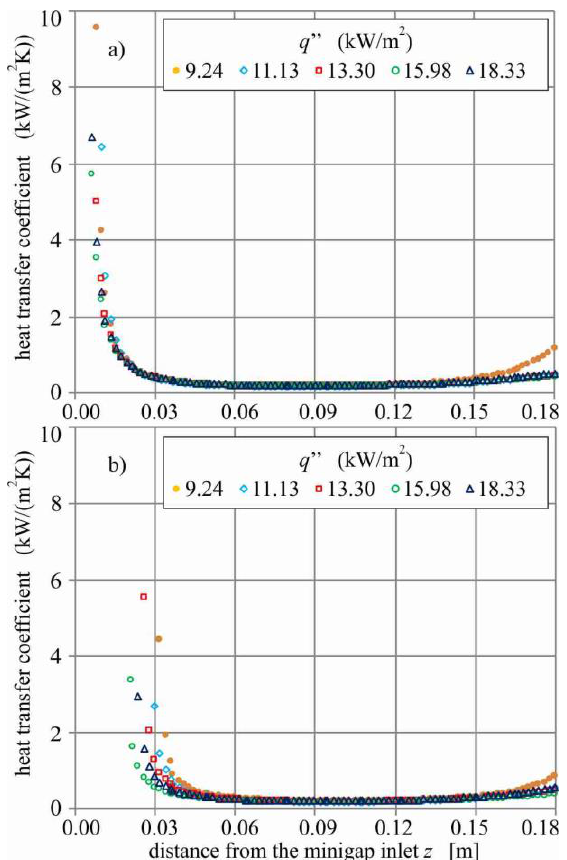
Figure 6. Heat transfer coefficient vs. the distance from the minigap inlet, computed with: ( a ) formula (10) and ( b ) formula (18).